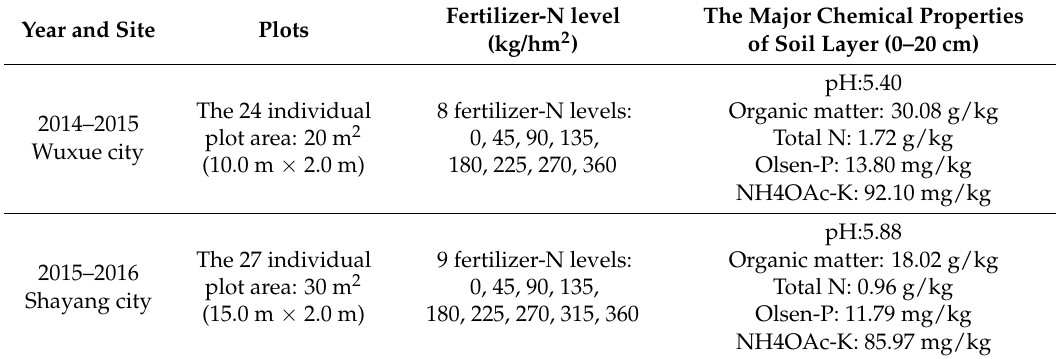
Table 1. Details of two field